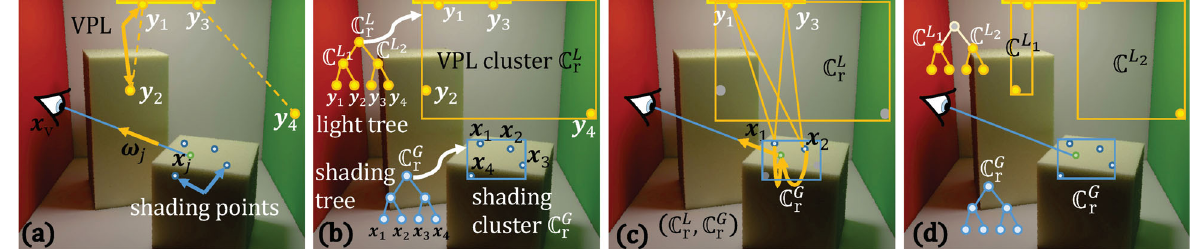
Fig. 3 Overview of our method, explained for rendering translucent materials. (a) Subsurface scattering of light at x j is calculated by generating shading points x i , which are importance sampled. (b) A VPL cluster C L r and shading cluster C G r are constructed. (c) Two VPLs and shading points from each cluster are sampled from the pair ( C L r , C G r ), then the pixel value ˆ I , error Δˆ I , and standard deviation are estimated. (d) One of the clusters is subdivided if the estimated error Δˆ I is greater than tolerance (cid:2) ˆ I . A cluster is selected based on the length of the diagonal of its bounding box weighted by the numbers of VPLs and shading points in each cluster. Here, the VPL cluster C L r is selected and replaced with two child nodes C L 1 and C L 2 ; two new pairs ( C L 1 , C G r ) and ( C L 2 , C G r ) are created. The pixel value is estimated from the two pairs ( C L 1 , C G r ) and ( C L 2 , C G r